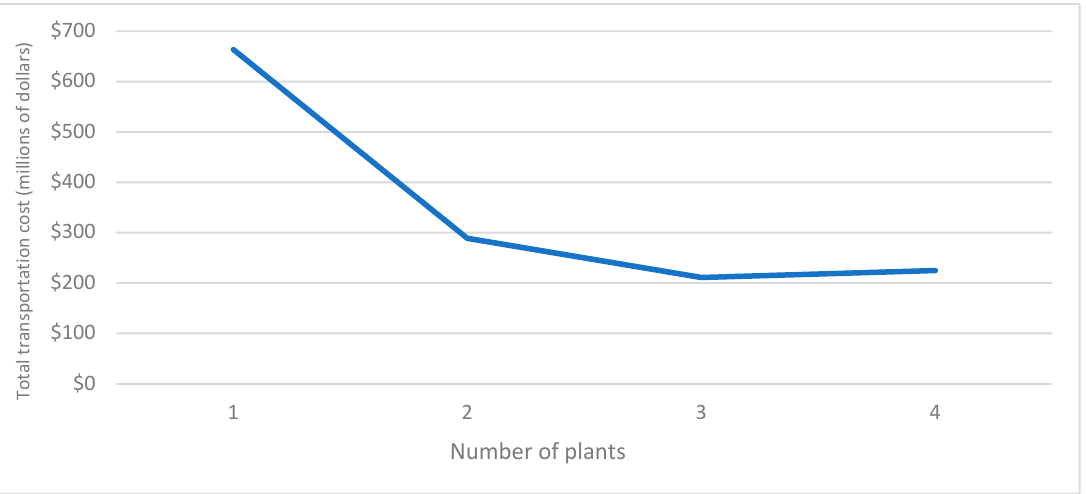
Figure 6. Variation of total transportation cost with number of plants.